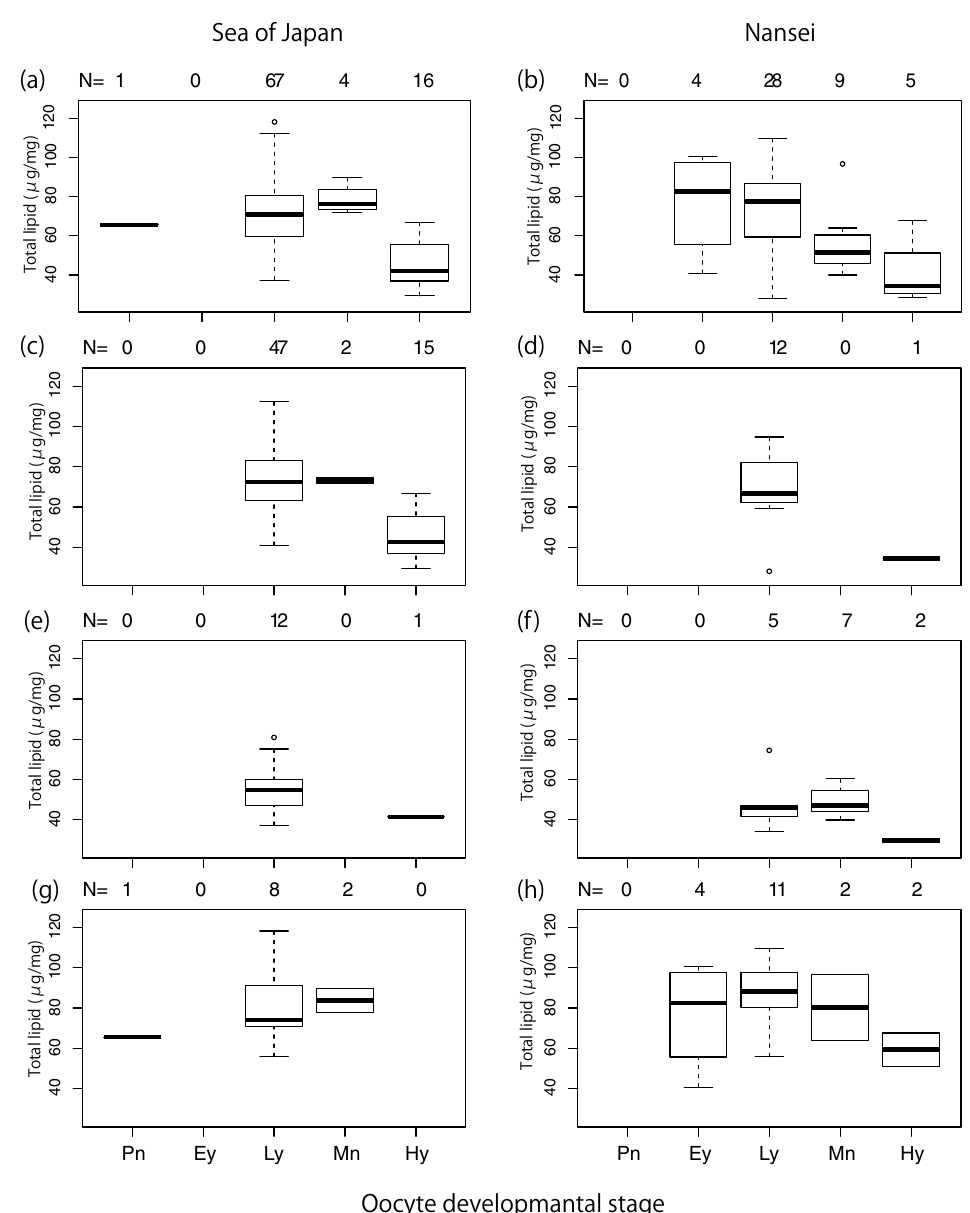
Fig 2. Box plots for total lipids in ovary tissues, separated by oocyte developmental stage: Sea of Japan, all years combined (a), and separately for 2015 (c), 2016 (e) and 2017 (g); and Nansei Island, all years combined (b), and separately for 2015 (d), 2016 (f) and 2017 (h). Oocyte stage: Pn, perinucleous; Ey, early yolked; Ly, late yolked; GVM, germinal vesicle migration; Hy, hydrated.